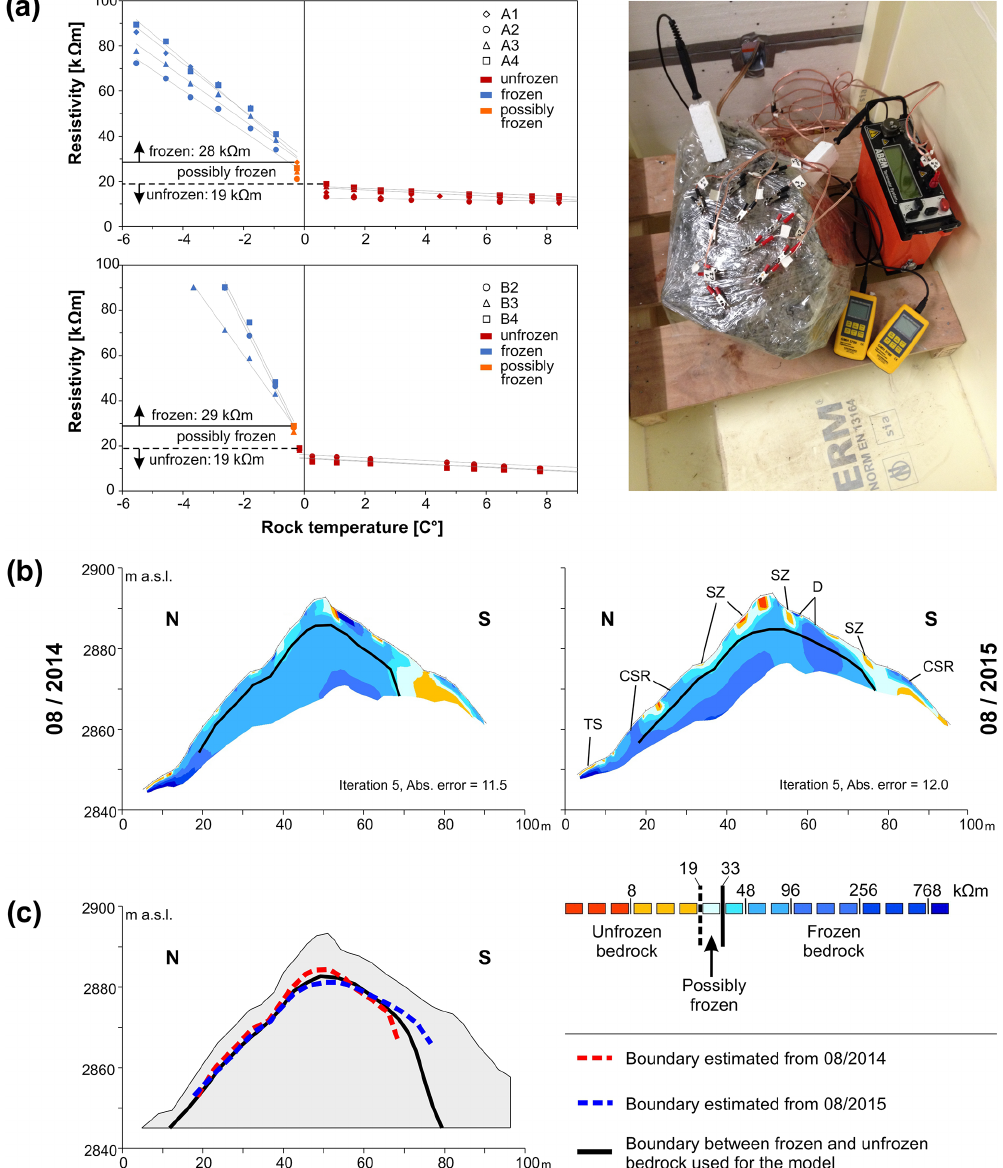
Figure 4. The left side of panel (a) shows the laboratory-tested electrical resistivity of frozen and unfrozen Wetterstein limestone collected at the study site. The definition of frozen (blue symbols), unfrozen (red symbols) and possibly frozen (orange symbols) electrical resistivity is based on the freezing trajectories of two rock samples. Measurements were performed along different Wenner arrays (i.e. A1–A4 or B2–B4) installed parallel to each other. The right side of panel (a) outlines the test set-up in the laboratory cooling box. (b) The distribution of frozen and unfrozen bedrock in the Zugspitze summit crest was derived from two ERT surveys in August 2014 and August 2015. TS represents the Talus slope; CSR stands for compact solid unfrozen rock; SZ corresponds to the shear zone; D represents doline. Panel (c) displays the current spatial extent of bedrock permafrost, which was estimated from the ERT campaigns and used for the numerical